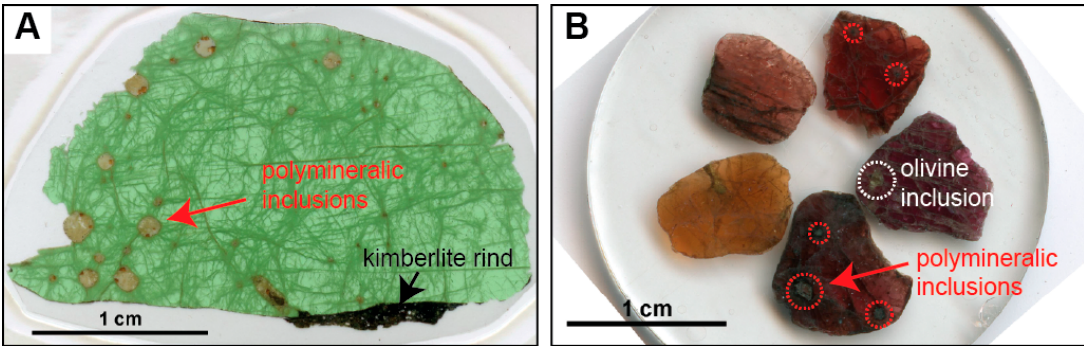
Figure 1. Photomicrographs of polymineralic inclusions within a clinopyroxene megacryst ( A ) and within garnet macrocrysts that possibly constitute fragments of larger megacrysts ( B ), from the Diavik diamond mine, Slave craton, Canada (modified after Bussweiler et al. [44]; their Figure 2. Polymineralic inclusions are typically located where fractures or veinlets in the host megacryst converge, and are surrounded by trails of smaller melt inclusions and fluid inclusions. Polymineralic inclusions are optically distinct from late-stage groundmass kimberlite (see kimberlite rind in ( A )) and altered mineral inclusions (see olivine inclusion in ( B )).